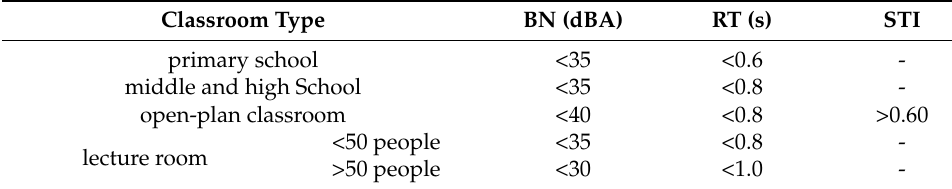
Table 2. The acoustic performance standard for the classroom in the UK (unoccupied).